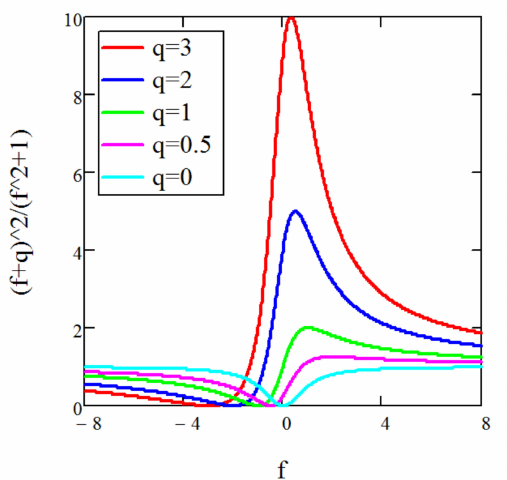
Figure 24. Fano resonance phenomenon in photonics (Adapted with permission from Ref [76]. Copyright 2017, Springer